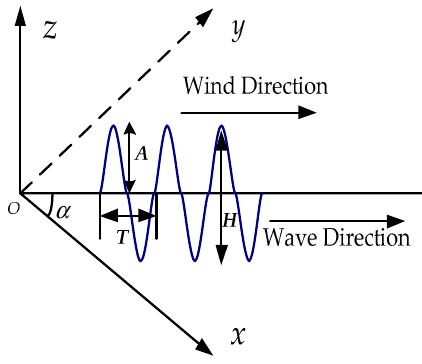
Figure 4. Schematic diagram of a long wave.